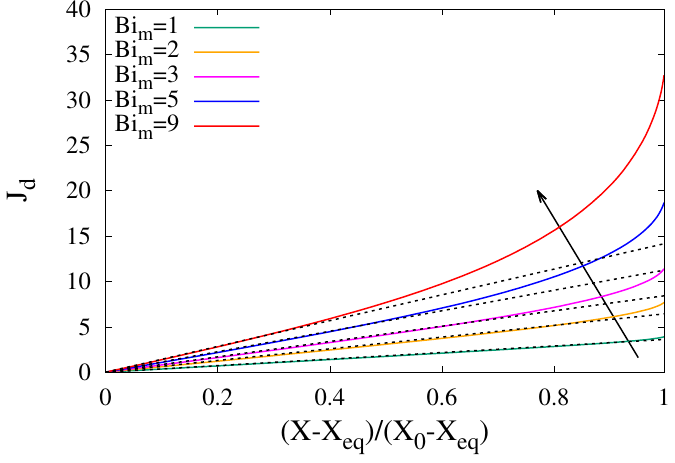
Figure 5. Dimensionless dehydration rate J d vs. moisture ratio X r = ( X − X eq ) / ( X 0 − X eq ) for Bi m = 1,2,3,5,9 for a uniform initial water distribution, X core increasing values of Bi m . Dashed lines indicate the theoretical long-drying time-scales linear behaviour, Equation